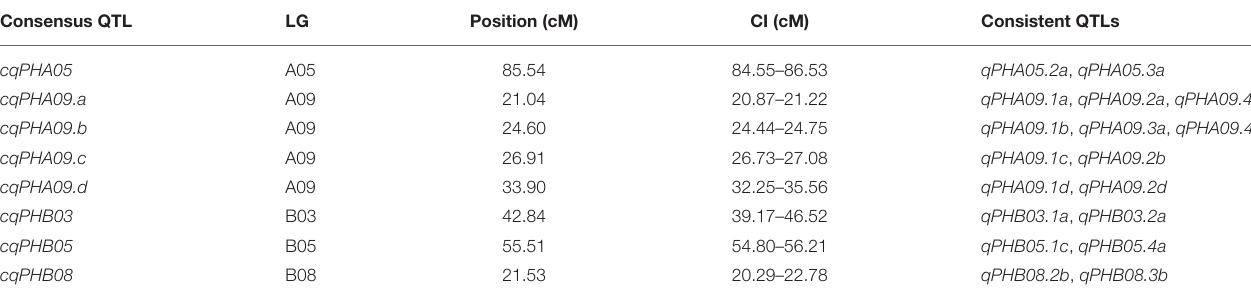
TABLE 4 | Consensus QTLs of plant height through meta-analysis in multiple